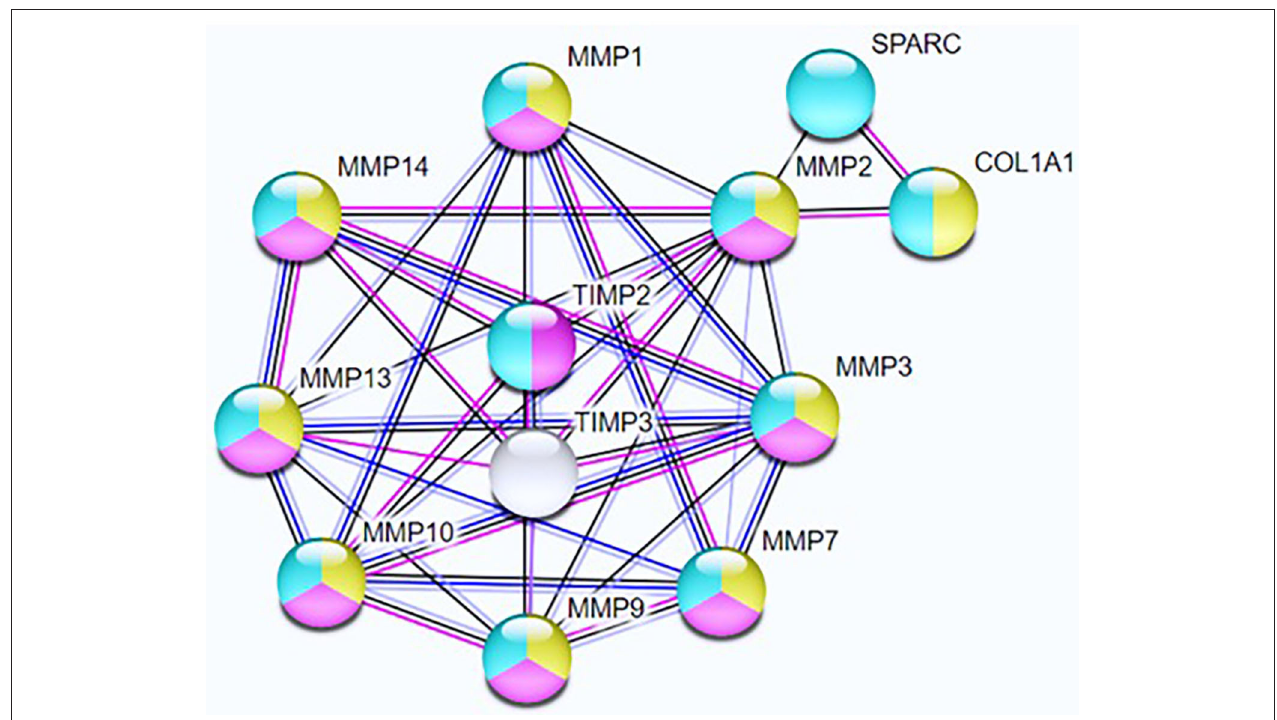
FIGURE 2 | Network nodes represent query proteins and first shell of interactors; yellow nodes = collagen metabolic process; pink nodes = extracellular matrix disassembly; blue nodes = extracellular matrix organization. Line color indicates the type of interaction evidence; Blue lines represent gene co-occurrence, black lines represent co-expression, and pink lines represent experiment determined relations. Number of nodes = 12; number of edges = 36; average node degree = 6; average local clustering coefficient = 0.814; expected number of edges = 10; PPI enrichment p =